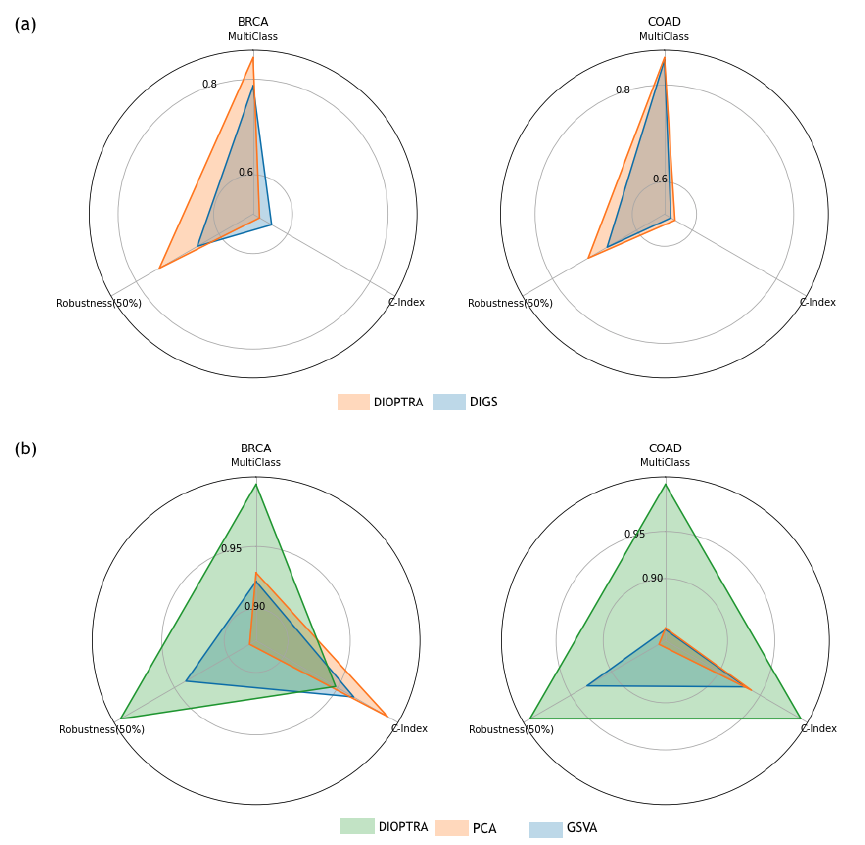
Figure 4. Radar charts; each vertex counter-clockwise from 12 o’clock of the radar chart indicates sample phenotype prediction accuracy on molecular subtypes, robustness against 50% perturbed genes, and survival regression as evaluated by C-index, respectively. ( a ) Comparison of the perfor- mance between DIOPTRA and the original DIGS. ( b ) Comparison of the performance between three representative methods (DIOPTRA, PCA, and GSVA). The number on each vertex is scaled to 0-1 for these two